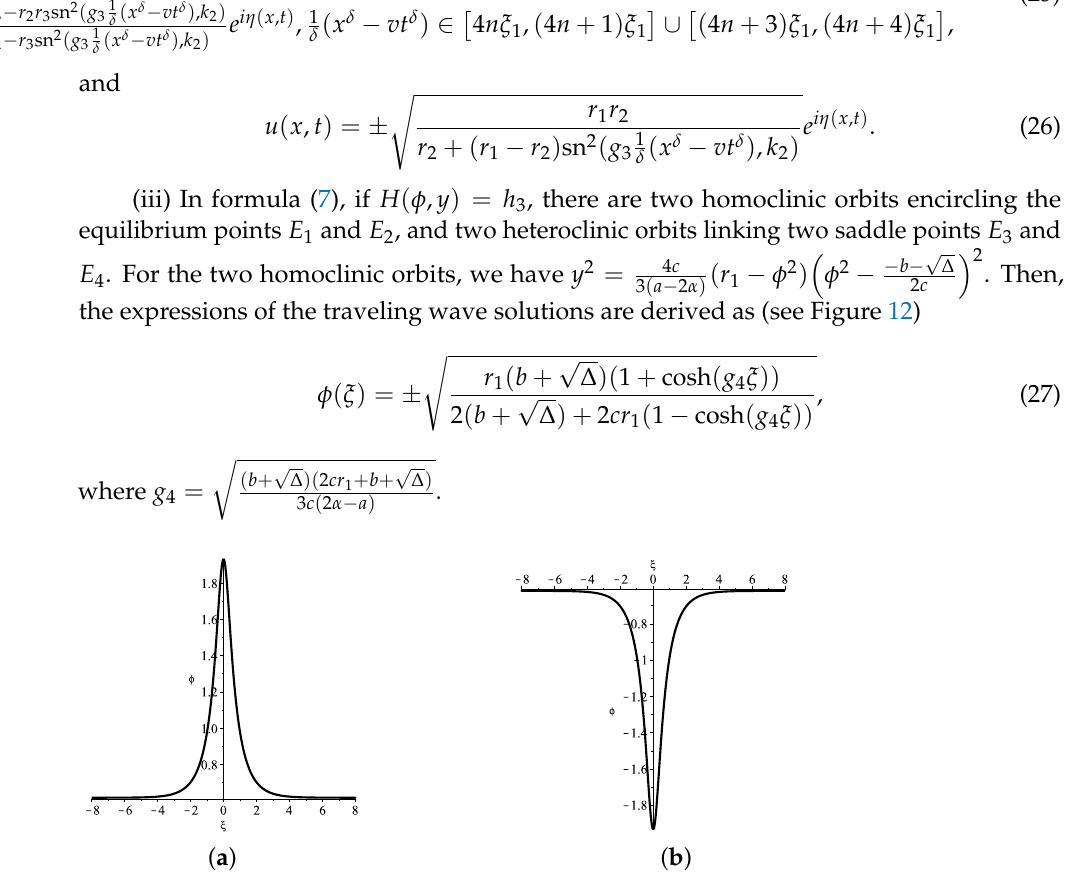
Figure 12. Solitarywave forms of system (5). ( a ) Bright solitary wave derived by (27) + . ( b ) Dark solitary wave derived by (27) −